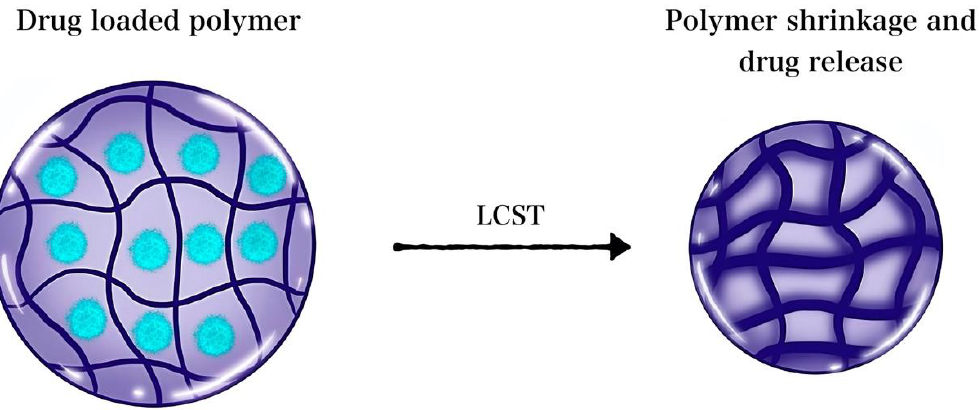
Figure 3. A schematic illustrating the ‘coil-to-globule’ phase transition of thermosensitive polymers upon exposure to heating above the LCST. The conformation change from the hydrated coil state (left) to the dehydrate globule state (right) results in drug release.